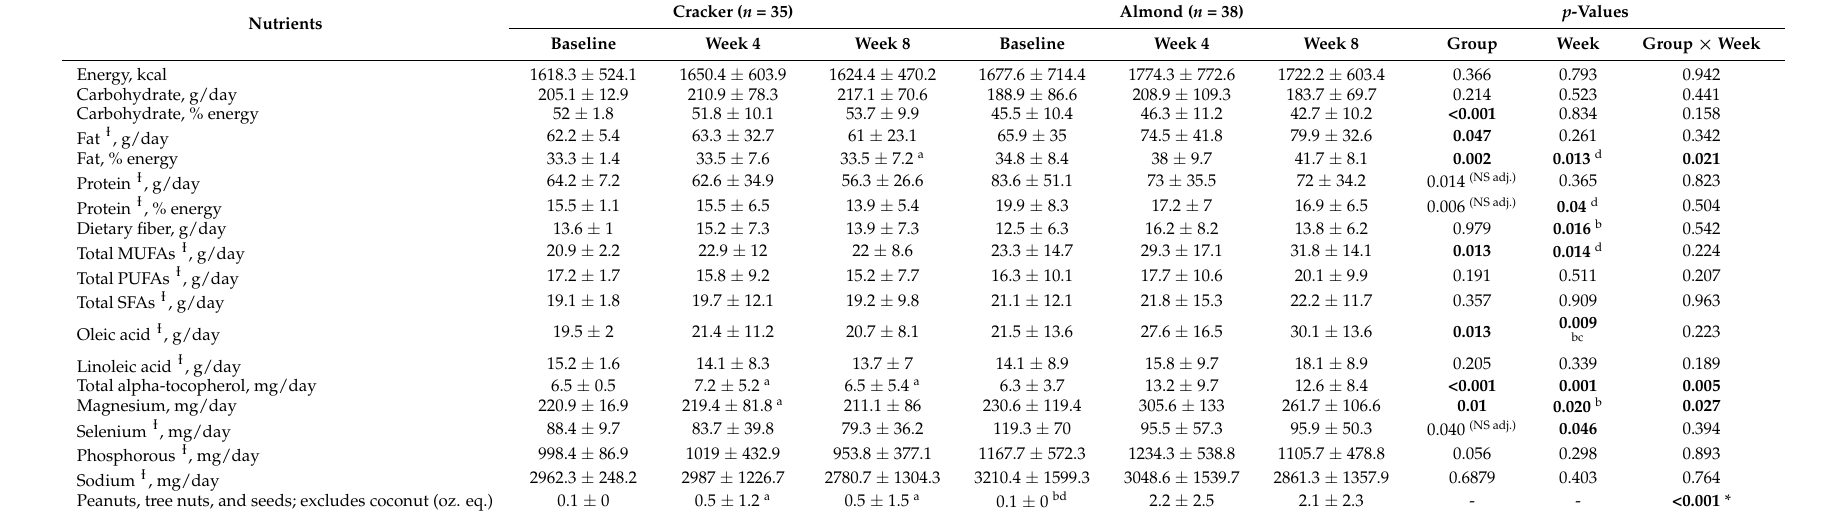
, values transformed prior to analysis using Johnson’s family of transformations,